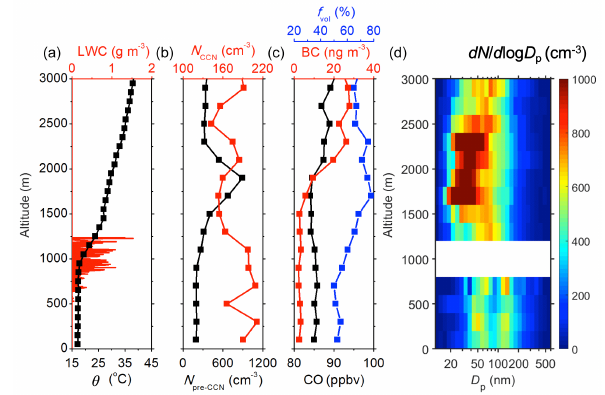
Figure 9. Vertical profiles of parameters under the synoptic condi- tion of Azores high on 8 July 2017. (a) Potential temperature ( θ ) and liquid water content (LWC). (b) N pre-CCN and N CCN . (c) Con- centrations of carbon monoxide (CO) and black carbon (BC), as well as the aerosol volatile fraction ( f v ). (d) Vertical contour of aerosol size distributions as a function of altitude. Size distribu- tions between 800 and 1200m are not shown due to the interference of cloud droplet shattering. The CO mixing ratio, BC concentra- tion, particle concentrations, and size distributions are normalized to standard temperature and pressure (273.15K and 101.325kPa;